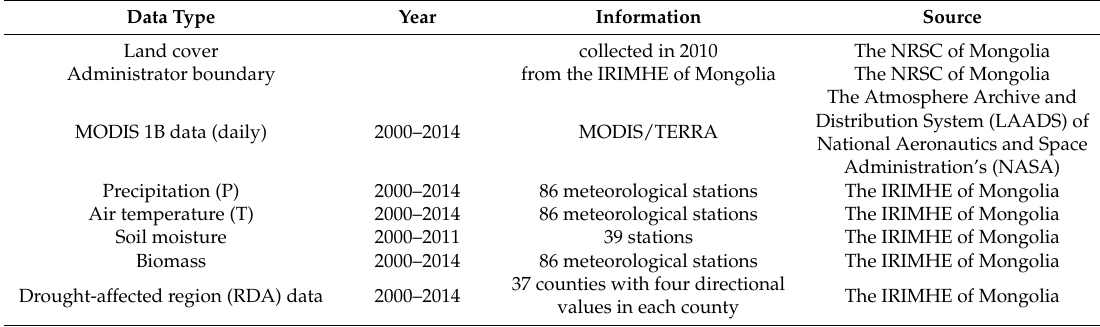
Table 1. Data used in this study.